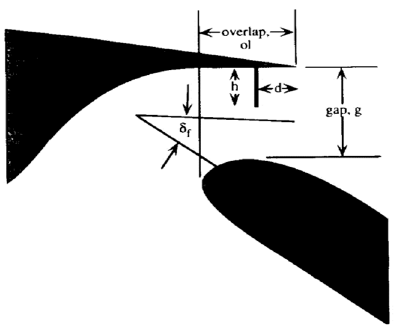
Figure 14. Flap positioning main parameters: gap and overlap definition.